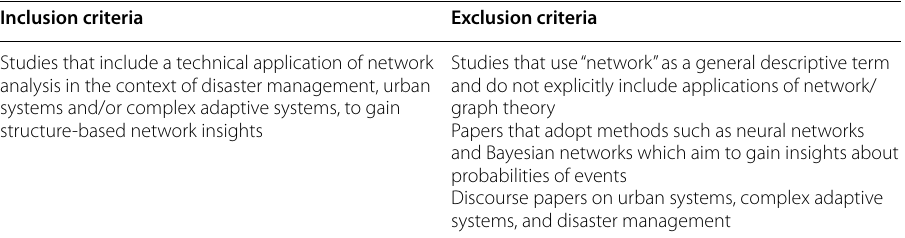
Table 1 Inclusion and exclusion criteria adopted to identify papers within the scope of the review Inclusion